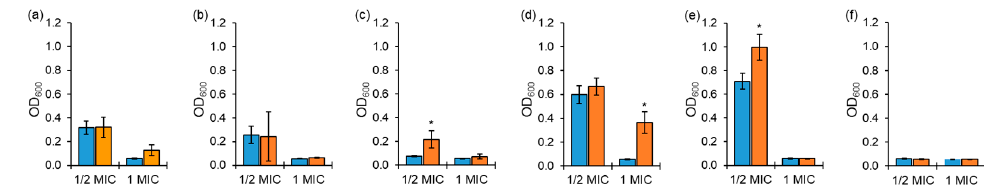
Figure 1. Growths of antibiotic-sensitive Salmonella Typhimurium ATCC 19585 (ASST) exposed to ½ and 1 MICs of chloramphenicol ( a ), erythromycin ( b ), tetracycline ( c ), cephalothin ( d ), ciprofloxacin ( e ), tobramycin ( f ) at 0 h ( ■ ) and 10 h ( ■ ) delayed inoculation. * indicates the significant difference within MIC at p < 0.05.